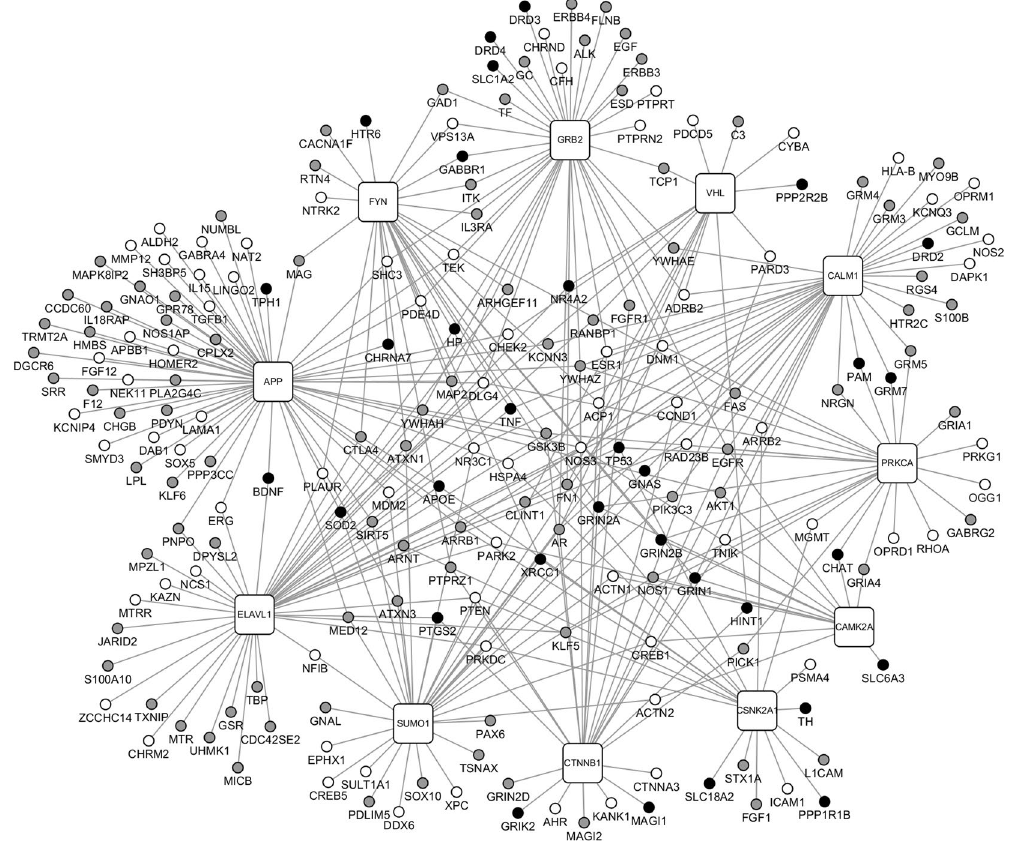
Figure 1. The predicted candidate genes and genes interacted with them in human PPI. Nodes shown in white, grey, and black represent genes associated with schizophrenia, nicotine addiction, or both diseases, respectively. The round rectangle nodes represent genes predicted to be associated with schizophrenia and nicotine addiction based on their network